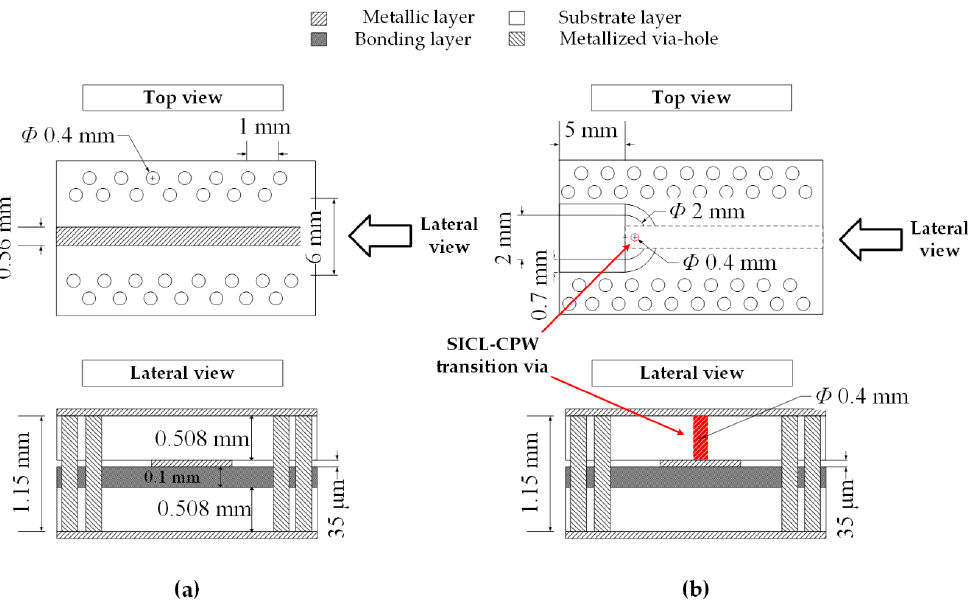
Figure 4. Substrate-integrated coaxial line (SICL) structure. ( a ) Transmission line: top and lateral views; ( b ) SICL to coplanar waveguide (CPW) transition: top and lateral views.